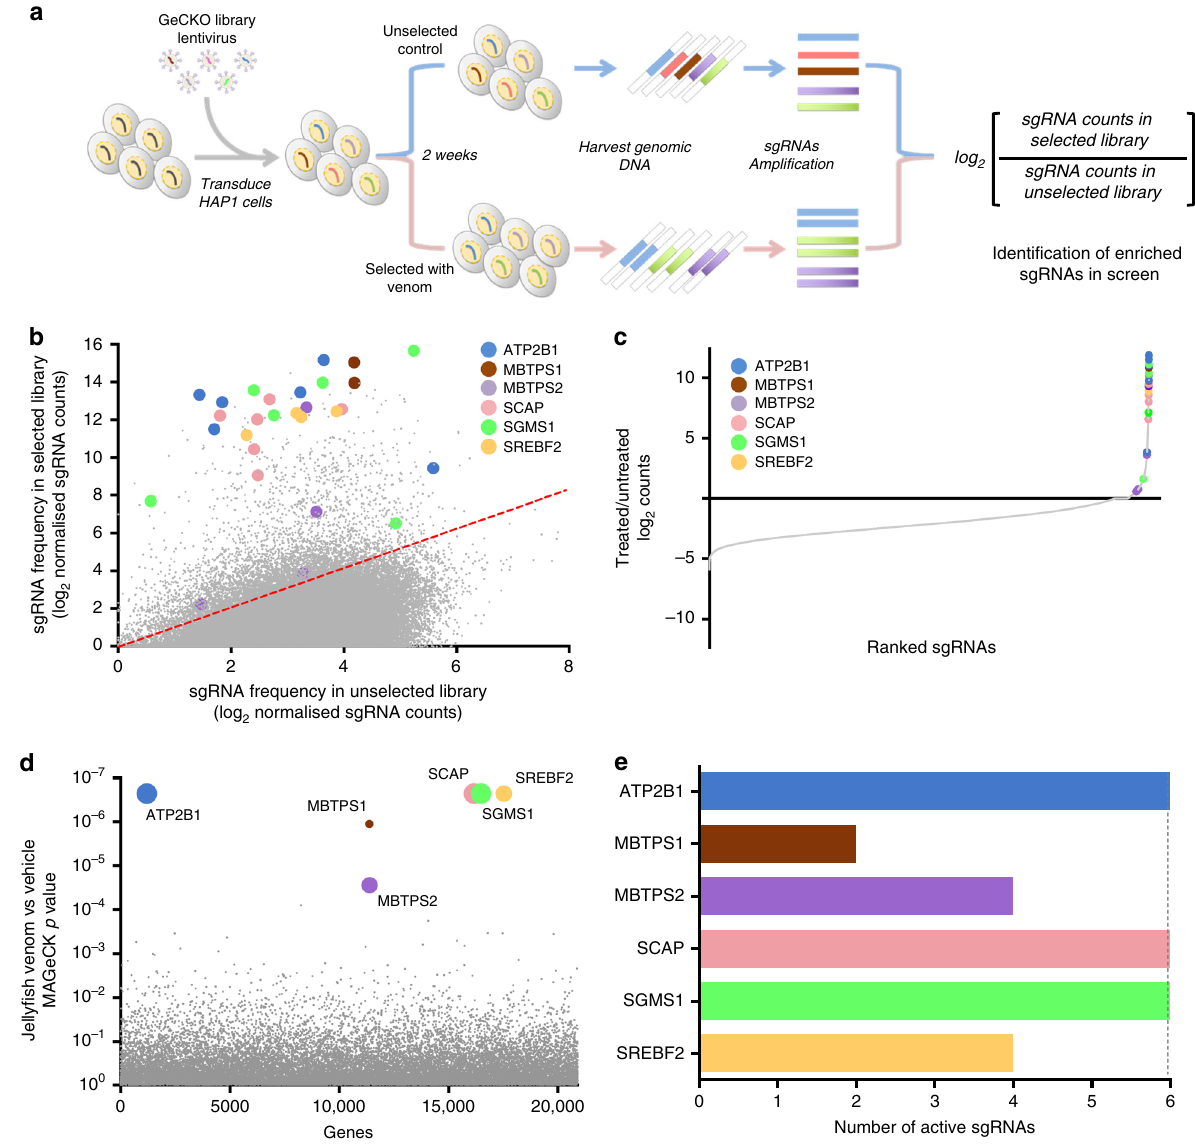
Fig. 2 A CRISPR-Cas9 knockout screen identi fi ed genes required for jelly fi sh venom killing. a Schematic design of pooled CRISPR library screens to identify the genes required for jelly fi sh venom killing. b Primary jelly fi sh venom screening data showing enrichment of speci fi c sgRNAs after the venom selection. The count for a sgRNA is de fi ned as the number of reads that perfectly match the sgRNA target sequence. c sgRNAs were ranked by their differential abundance between the treated versus untreated populations. d Top candidate genes identi fi ed by comparing differential abundances of all sgRNAs between the treated versus untreated populations using MAGeCK. Bubble size of top hits is proportional to the number of active sgRNA per gene. e The number of active sgRNAs for each of the screen